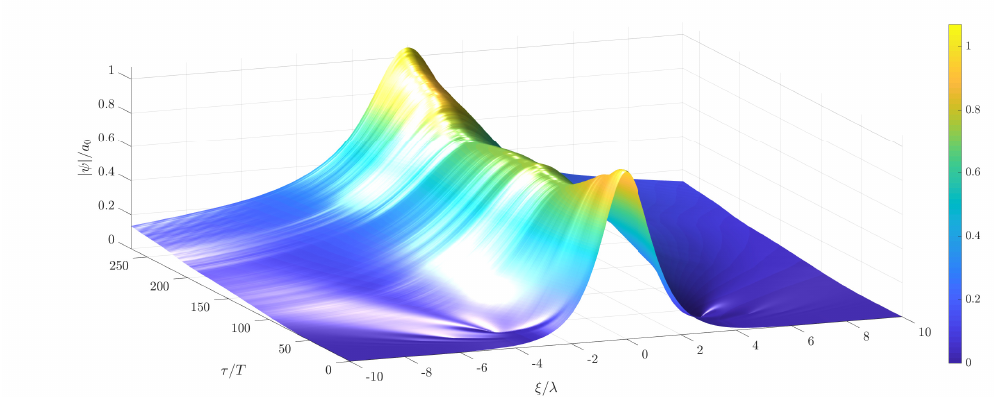
Figure 18. Temporal evolution of a soliton solution of the stochastic NLS with non-white noise excitation in time using laboratory scale parameters a 0 = 0.75 cm, ω = 10.68 rad/s, k = 11.64 1/m, mean wind velocity V m = 4 m/s and σ v = 2 m/s.